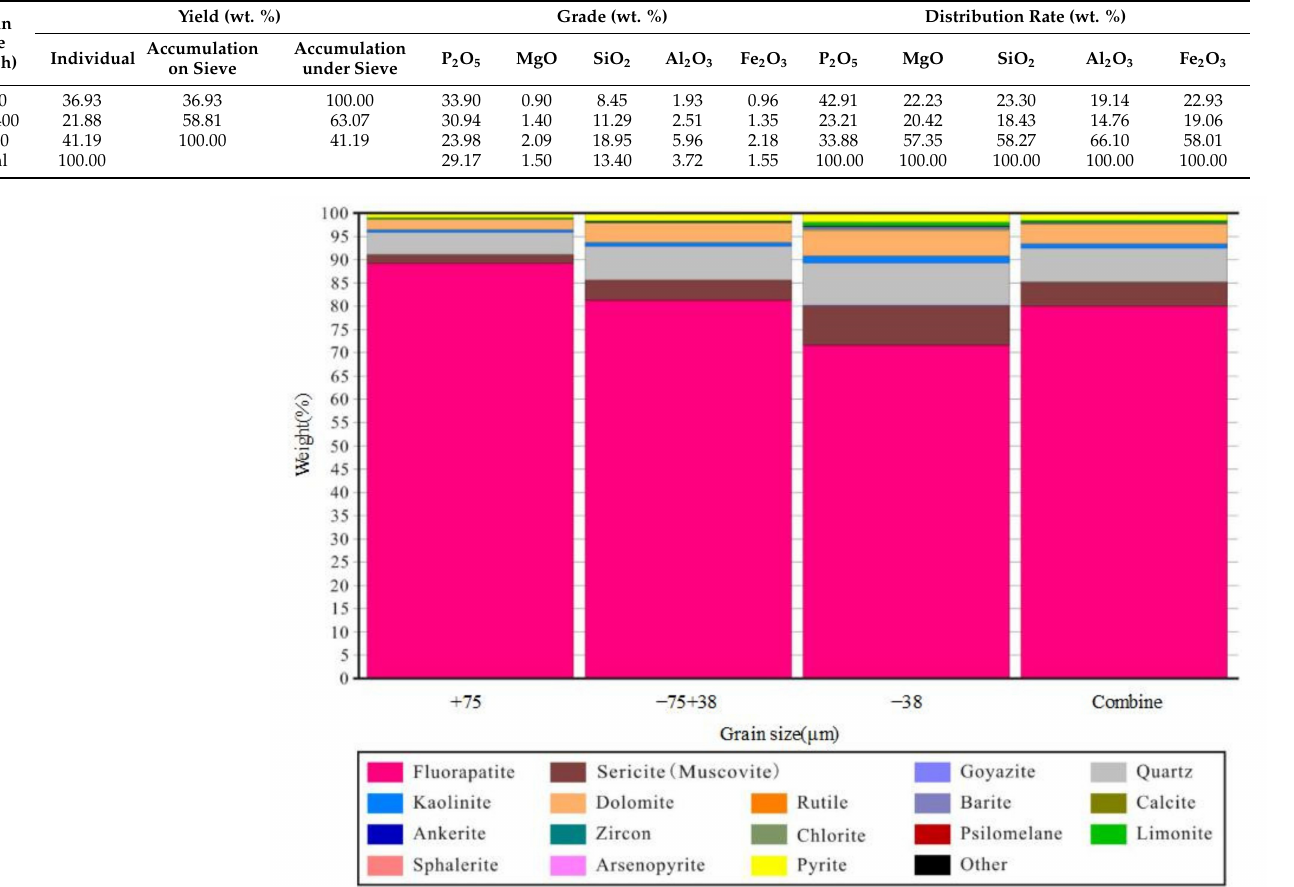
Figure 9. Histogram distribution of mineral composition in different grain size